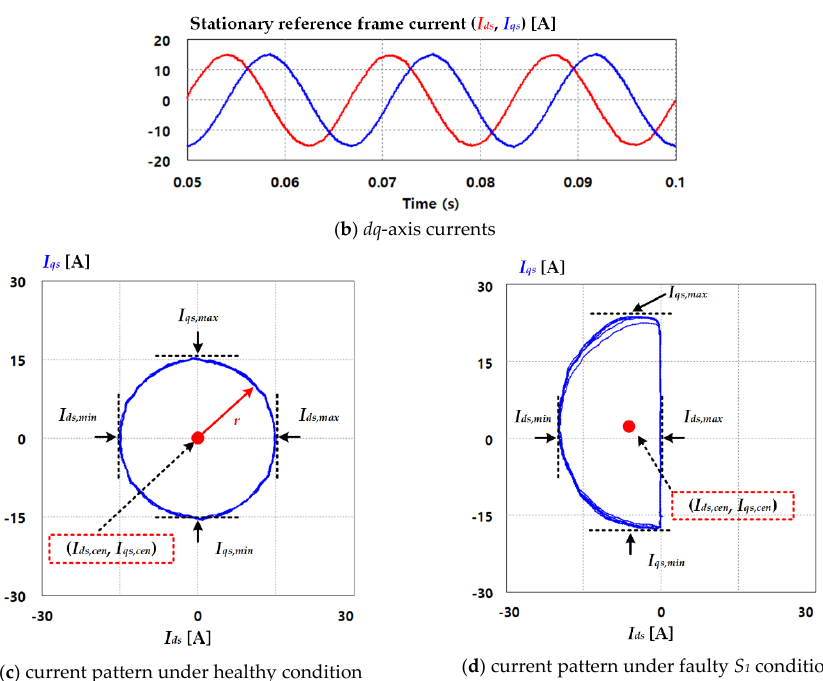
Figure 7. Output current waveforms and current pattern drawn by current vector.